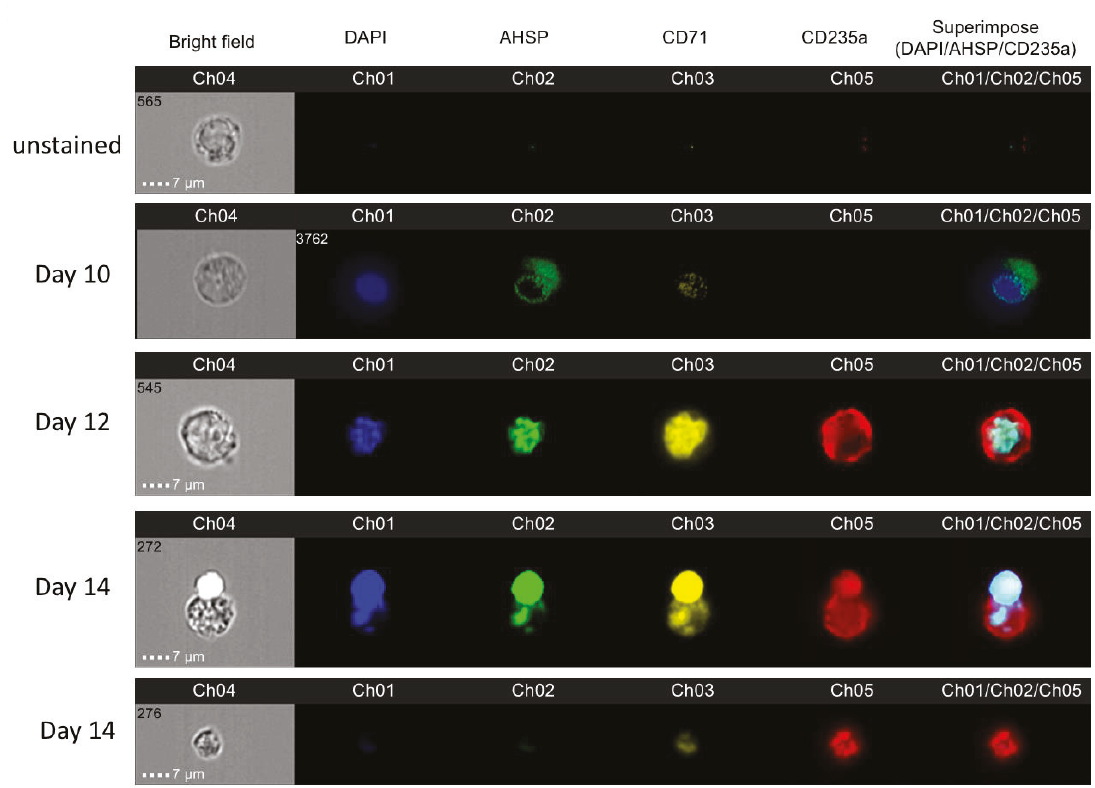
Figure 2. Representative images from AMNIS image flow of bone marrow derived erythroblasts on culture days 10, 12 and 14 with unstained cells for baseline comparison. Cells were examined in all four fluorescent channels and brightfield. Blue stain is the nuclear stain DAPI, green is the intra cellular AHSP marker, yellow is the transferrin marker CD71 and red is the glycophorin A marker CD235a. The superimposed image shows a combination of CD235a, AHSP and